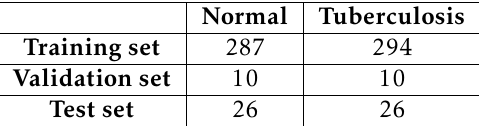
Table 4. Details about how India dataset is